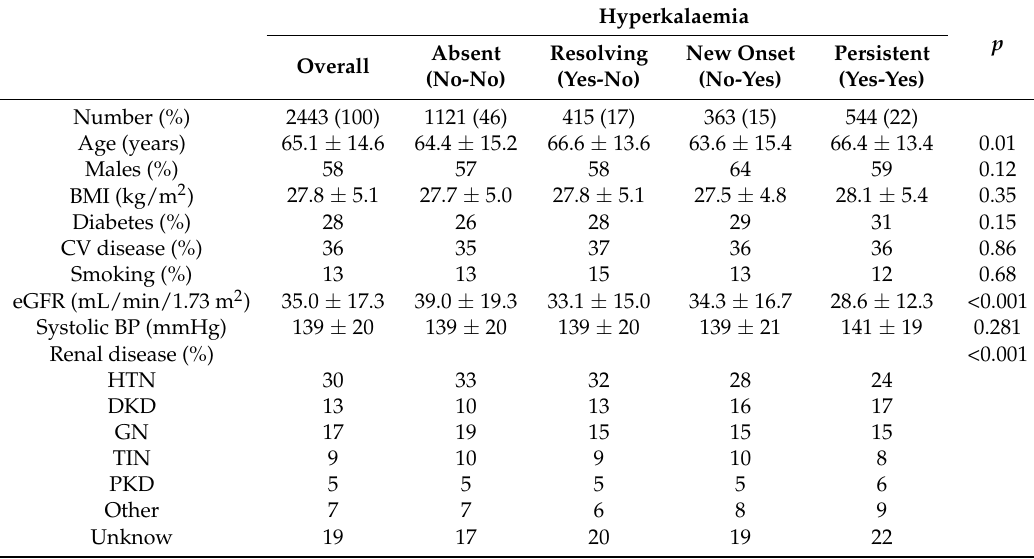
Table 1. Demographics of patients at Visit